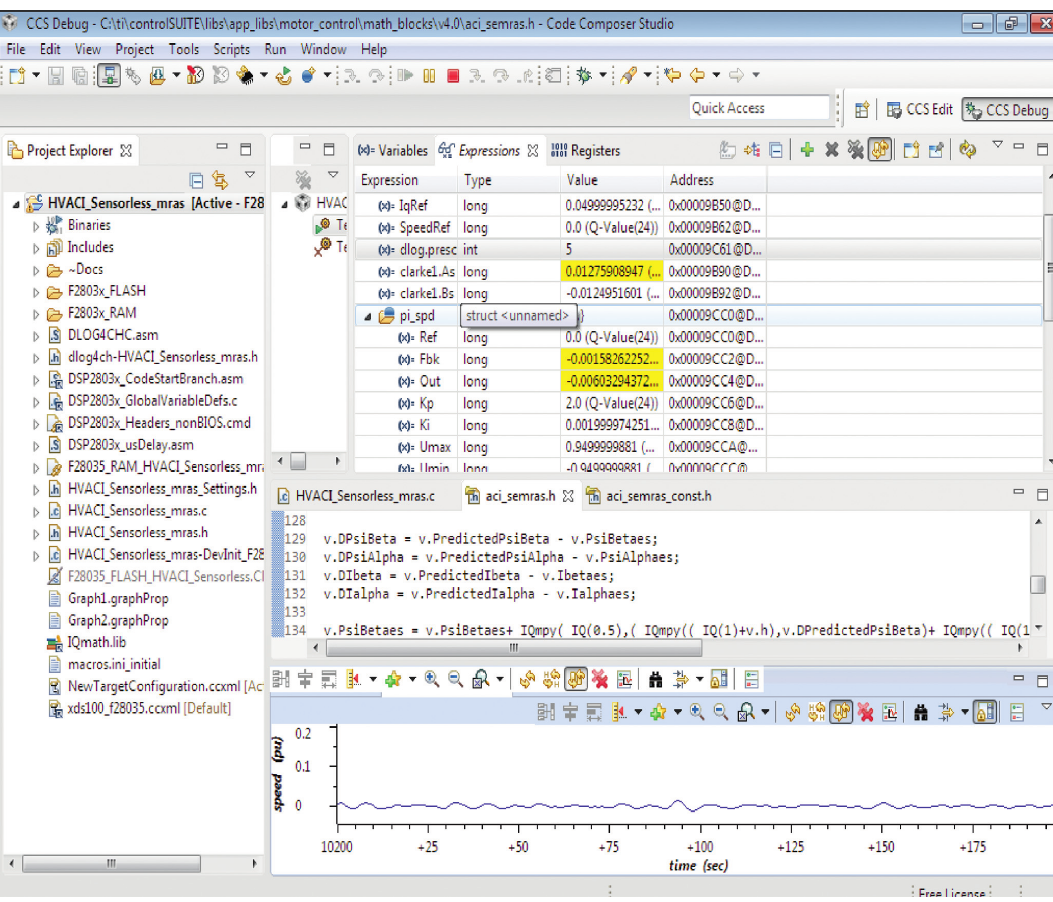
Figure 27: Rotor speed while the motor is running in a closed loop at 0.0